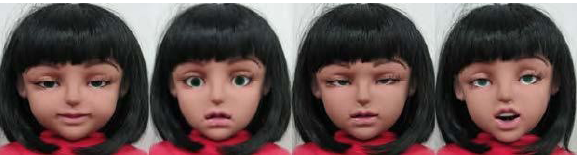
Figure 5: Image sequence from